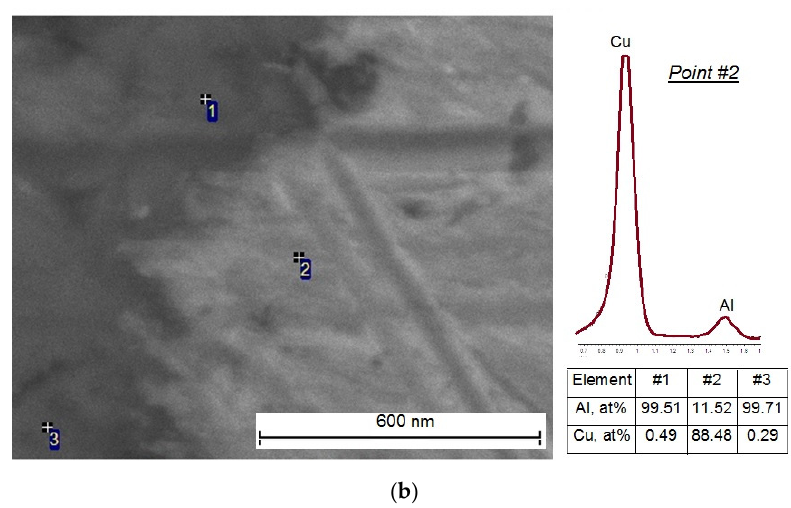
Figure 4. SEM-EDX analysis of selected points in the vicinity of the interface at two locations: ( a ) and ( b ).